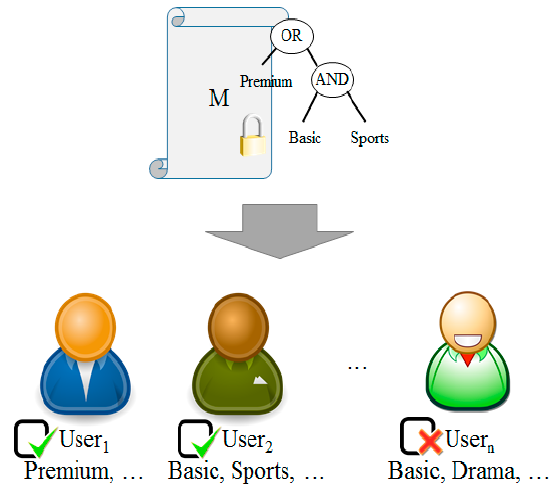
Figure 6. Ciphertext-Policy Attribute-Based Encryption.